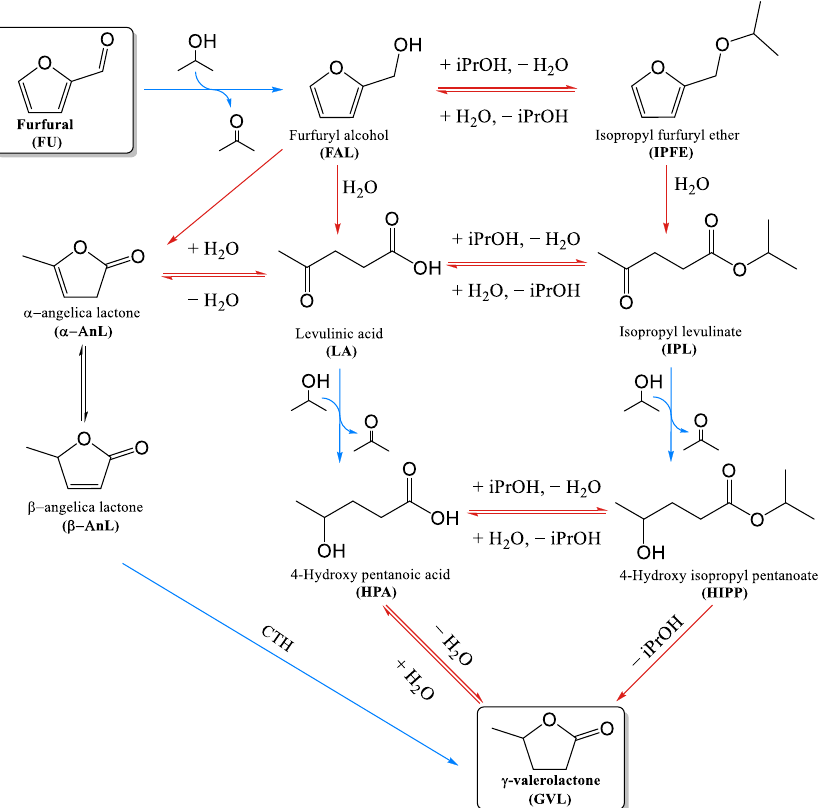
Figure 5. Detailed reaction scheme for the synthesis of γ -valerolactone from furfural. The blue arrows indicate Lewis acidity-catalyzed pathways while the red arrows indicate Brønsted acidity-catalyzed pathways.